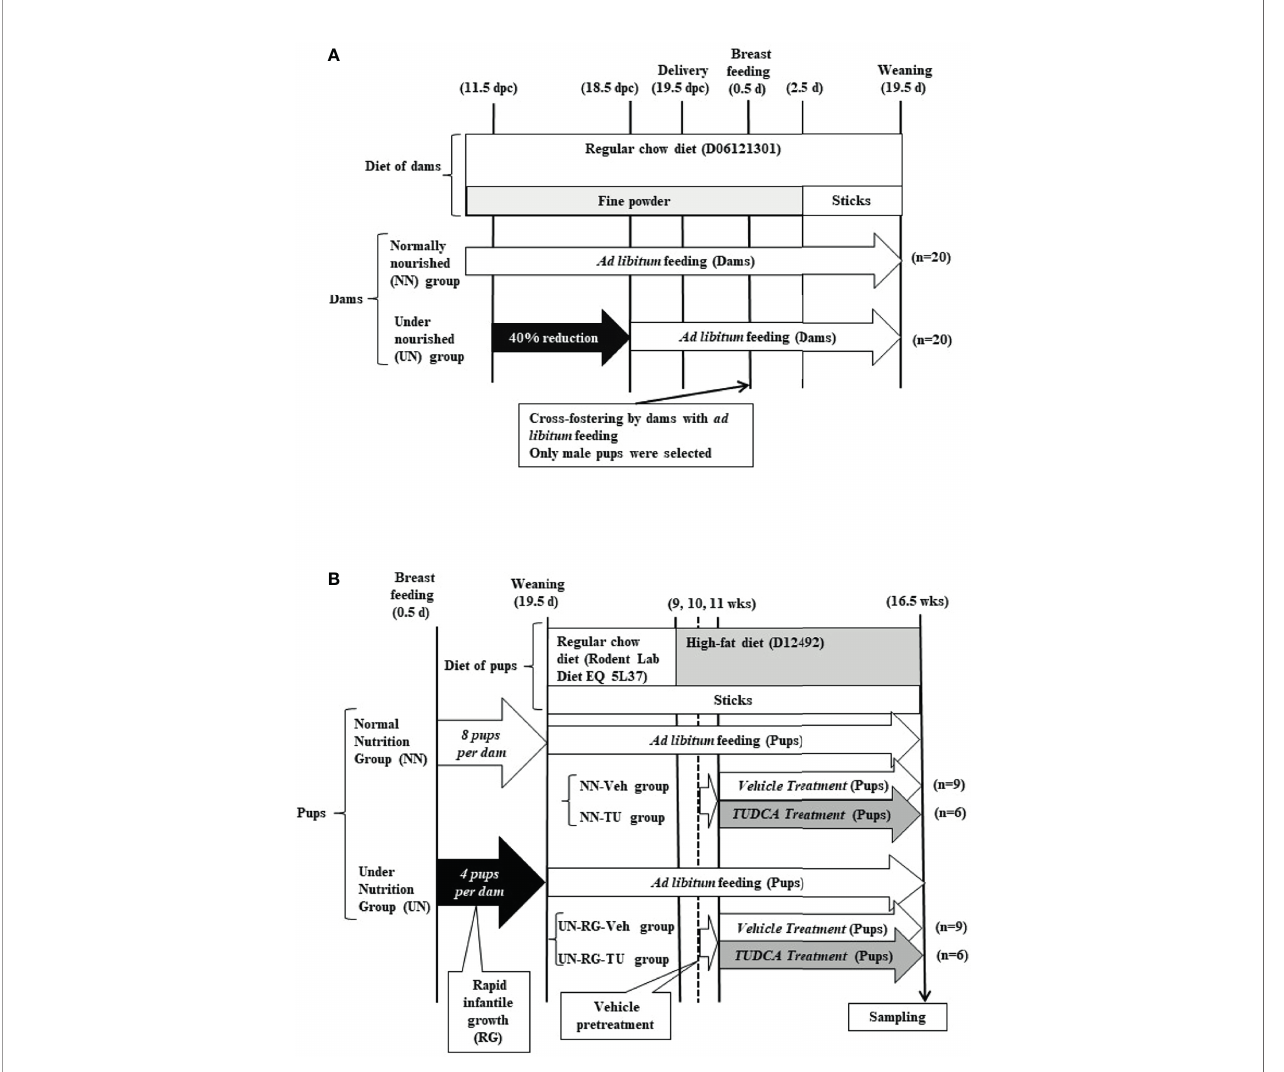
FIGURE 1 | Schematic illustration of experimental procedures in dams (A) and pups (B)